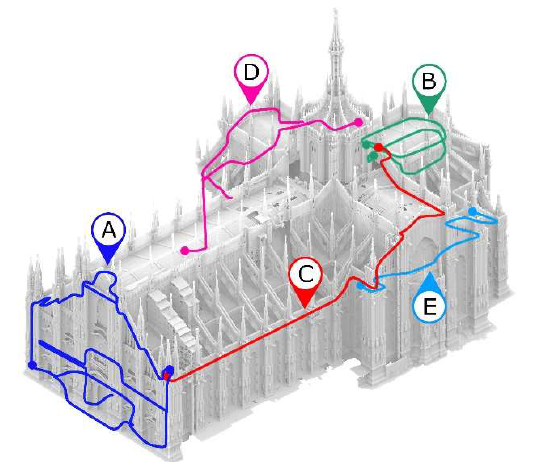
Figure 1. Picture of the prototype of the multicamera system.